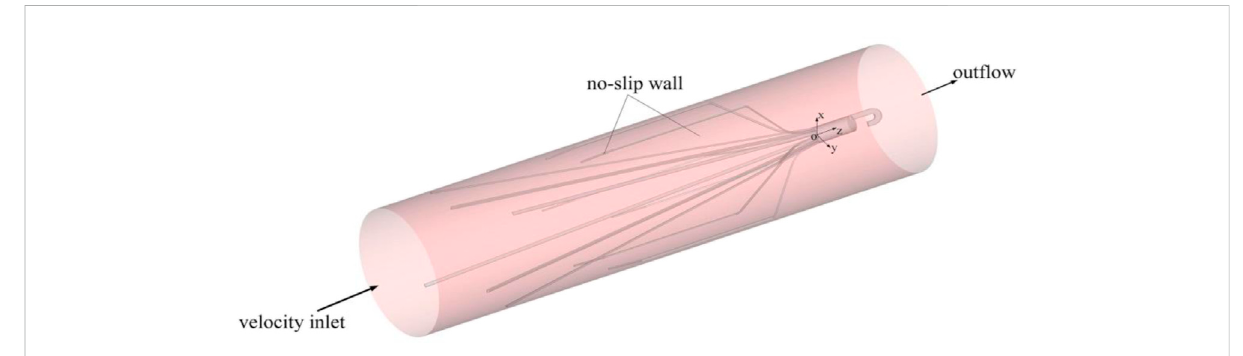
FIGURE 2 Filter in an IVC model and boundary conditions.